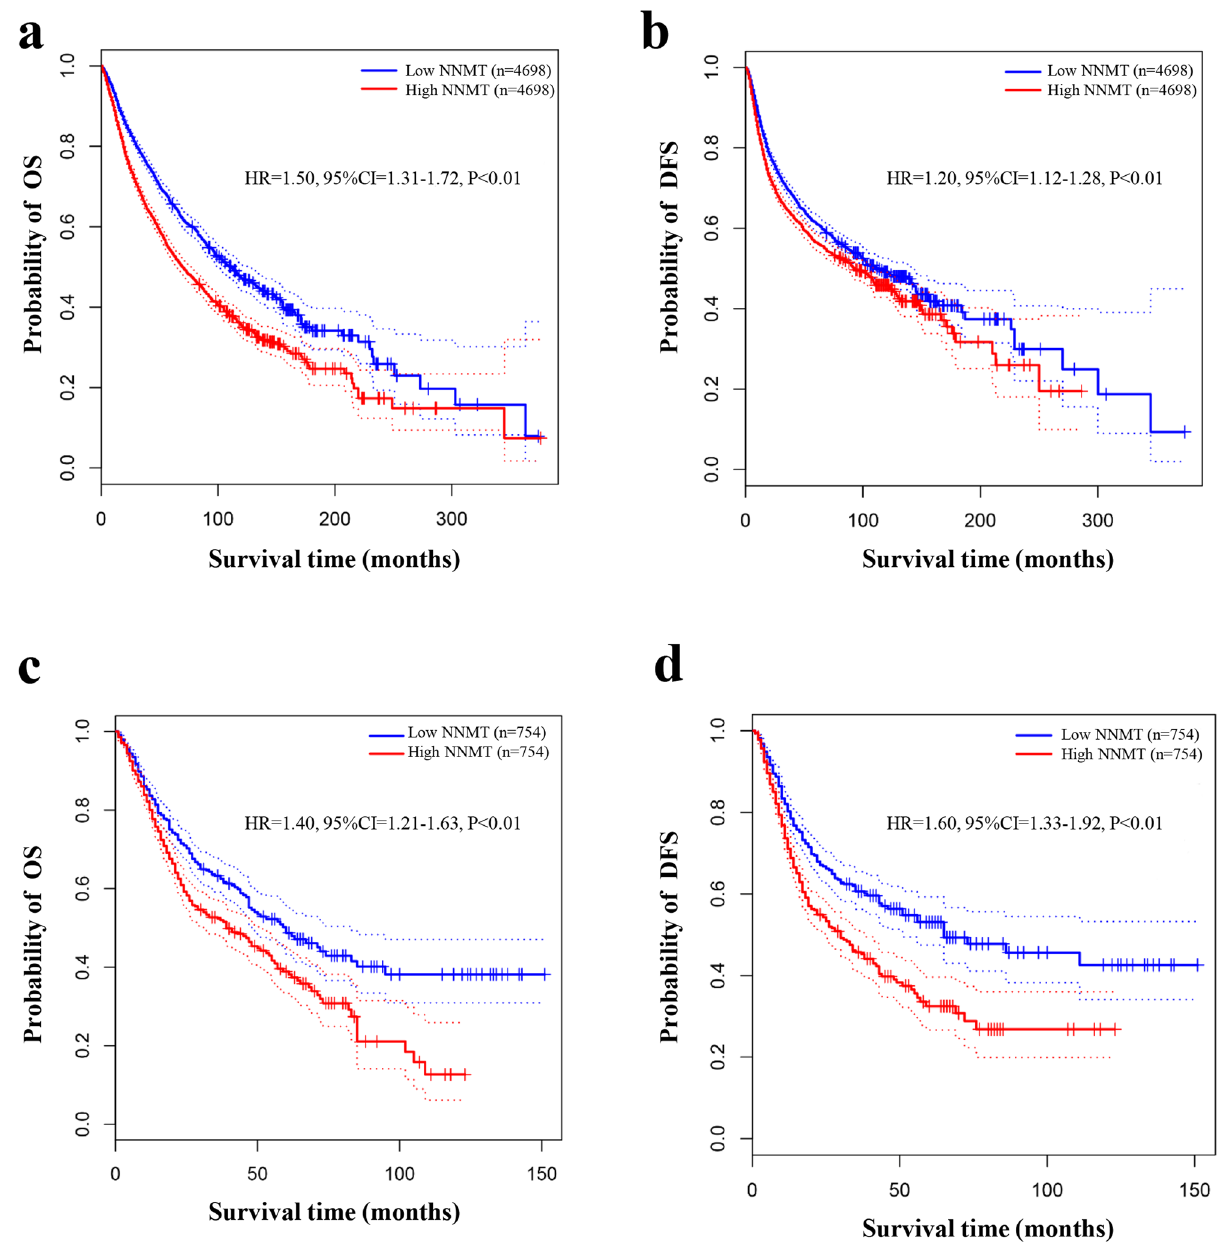
Figure 8: Database validation using TCGA data con fi rmed that high NNMT expression was signi fi cantly associated with worse OS and DFS in various cancers and gastrointestinal cancer: ( a ) OS for various cancers; ( b ) DFS for various cancers; ( c ) OS for gastrointestinal cancer; and ( d ) DFS for gastrointestinal